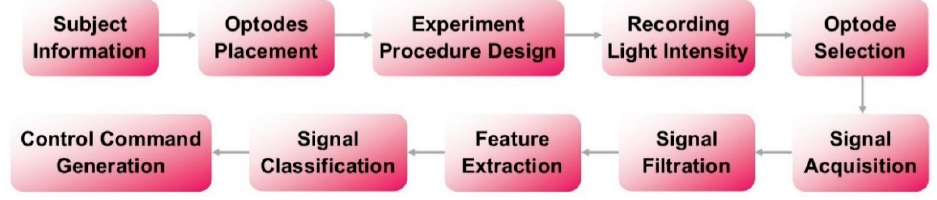
Figure 2. Methodology of the study.